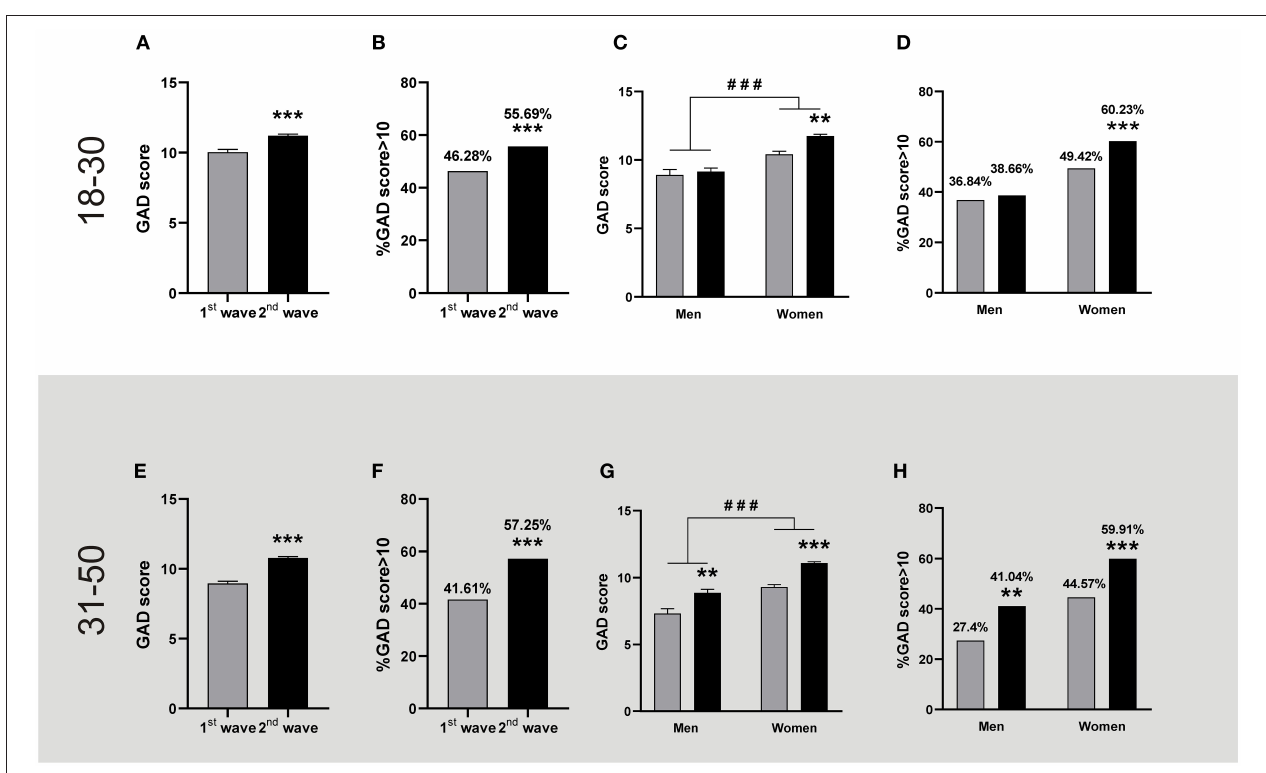
FIGURE 1 | GAD levels registered during the first and the second wave of COVID-19. The figures show the mean + SEM GAD scores or the percentage of people with GAD scores > 10 during the first (grey bars) and the second (black bars) wave. The descriptive statistics are reported in Supplementary Table 1 . Top panel: People aged between 18 and 30. (A) People reported higher GAD scores in the 2nd wave ( n = 1,844) than in the 1st wave ( n = 685). Mann-Whitney U -test, *** p < 0.001; Cohen’s d = 0.23. (B) The percentage of people with a GAD score > 10 was higher during the second wave; *** p < 0.001, X 2 , ϕ = 0.096. (C) Women but not men reported higher GAD scores in the 2nd wave. ### p < 0.001 women vs. men, and ** p < 0.01 vs. 1st wave after two-way ANOVA; Cohen’s f 2 = 0.23; η 2 p = 0.023 for the gender factor and η 2 p = 0.003 for wave factor (women: 1st wave n = 514, 2nd wave n = 1,456. Men: 1st wave n = 171, 2nd wave n = 388). (D) A higher percentage of women reported a GAD score > 10 during the 2nd wave; *** p < 0.001 vs. 1st wave, X 2 , ϕ = 0.10. Bottom panel: People aged between 31 and 50. (E) People reported higher GAD scores in the 2nd wave ( n = 2,732) than in the 1st wave ( n = 846). Mann-Whitney U -test, *** p < 0.001, Cohen’s d = 0.37. (F) The percentage of people with a GAD score > 10 was higher during the second wave; *** p < 0.001, X 2 , ϕ = 0.13. (G) Both genders reported higher GAD scores in the 2nd wave. ### p < 0.001 women vs. men, and ** p < 0.01 and *** p < 0.001 vs. 1st wave after two-way ANOVA; Cohen’s f 2 = 0.49 and 0.31 for men and women respectively; η 2 p = 0.016 for the gender factor and η 2 p = 0.010 for wave factor (Women: 1st wave n = 700, 2nd wave n = 2,347. Men: 1st wave n = 146, 2nd wave n = 385). (H) A higher percentage of women and men reported GAD scores > 10 during the 2nd wave; ** p < 0.01 and *** p < 0.001 vs. 1st wave, X 2 ., ϕ = 0.13 for both men and